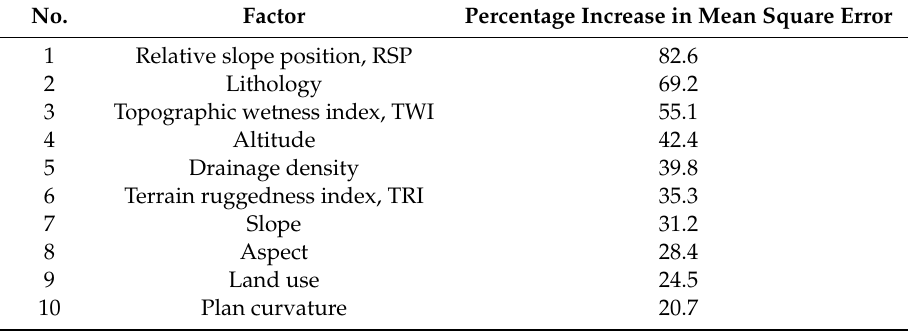
Table 6. Results of variable importance analysis of groundwater conditioning factors using the Random Forest (RF)